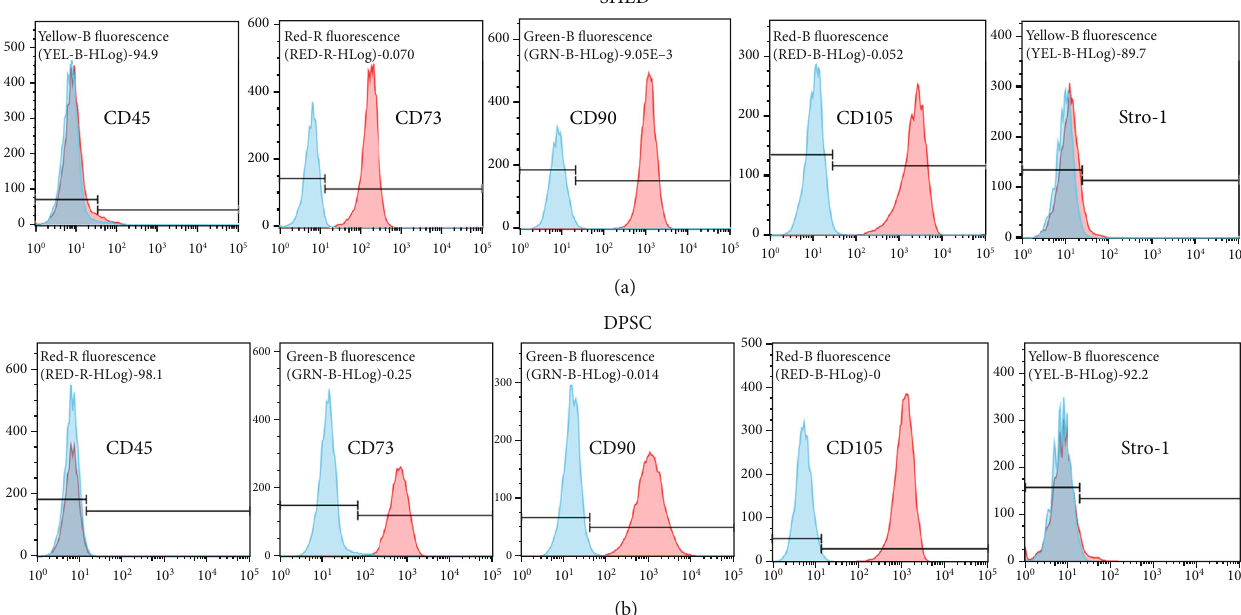
Figure 2: Characterization of cell surface markers of stem cells from human exfoliated deciduous teeth (SHEDs) and postnatal human dental pulp stem cells (DPSCs). Flow cytometry results for the detection of mesenchymal stem cell markers CD45, CD73, CD90, CD105, and STRO- 1 of (a) SHED and (b) DPSC.